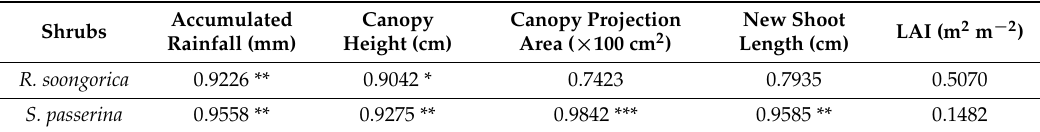
Table 5. Summary of correlations (Pearson) between the accumulated transpiration (mm) by Lysimeter measurement and the accumulated rainfall and shrubs morphological traits during the experimental period.